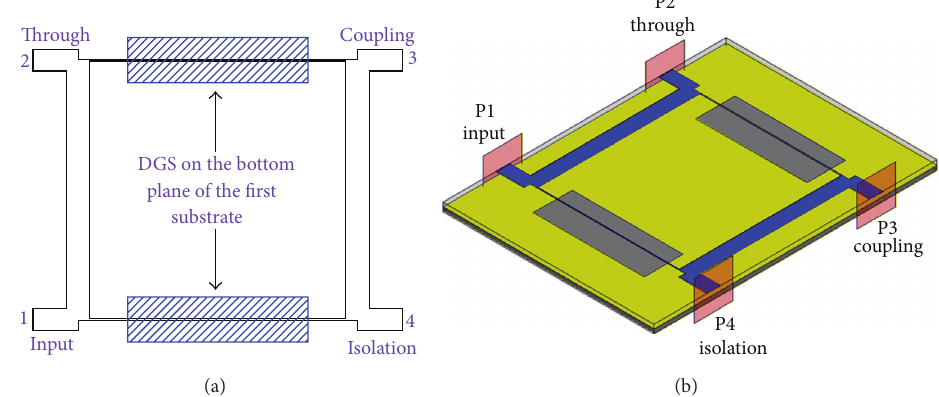
Figure6:Layoutoftheproposed10 dBhybridcouplerusingDGSanddouble-layeredsubstrate:(a)2-dimensionalviewand(b)3-dimensional view.